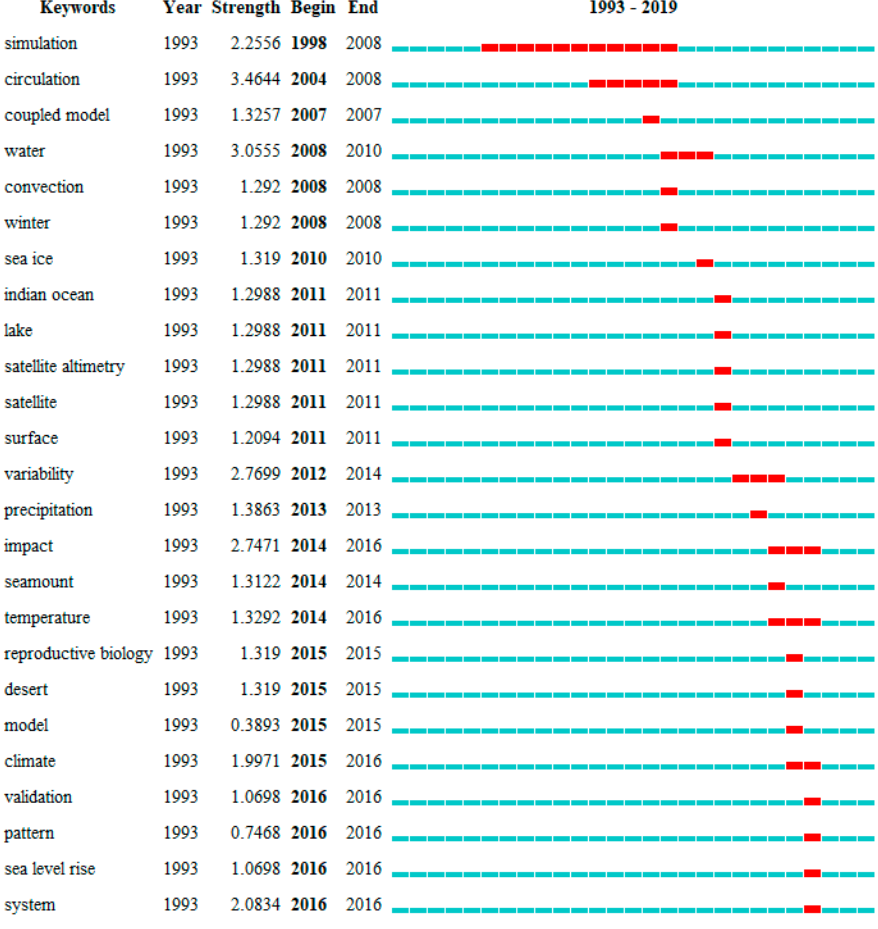
Figure 11. Top 25 keywords with strongest citation bursts.